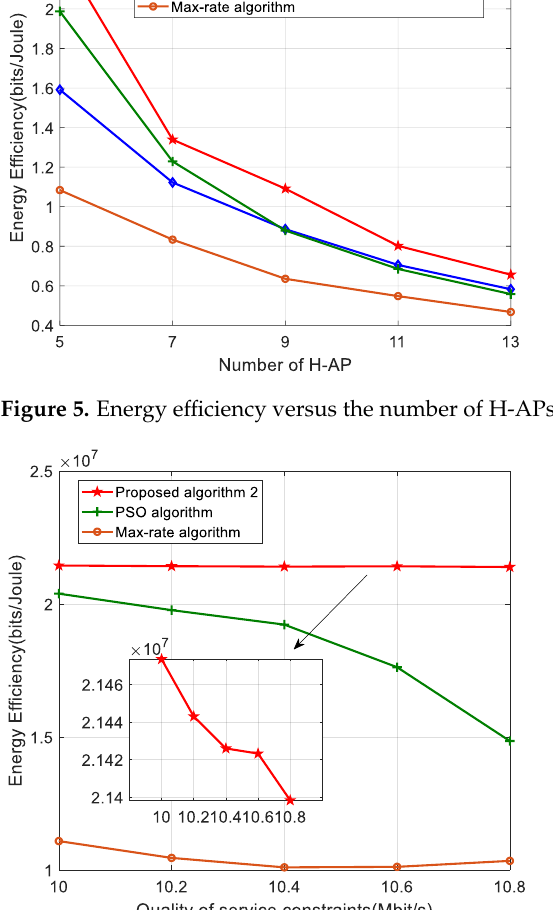
Figure 5. energy efficiency versus the number of H-APs for different algorithms.